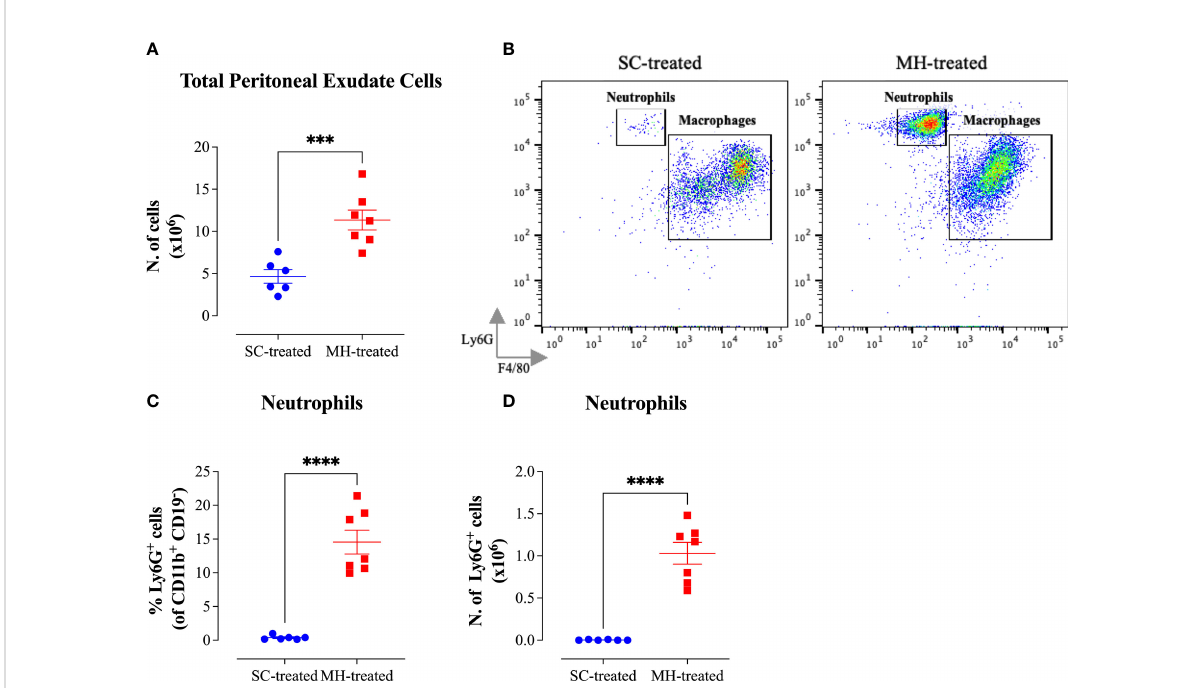
FIGURE 6 Cellular alterations in the peritoneal cavity following MH administration in C3H/HeJ mice. (A) Total number of PECs following treatment with SC or MH. (B) Representative dot plots showing Ly6G + neutrophils and F4/80 + macrophages within the PECs (gated on CD11b + CD19 - CD11c - cells). (C, D) Quanti fi cation of the percentage (C) and absolute number (D) of neutrophils (Ly6G + cells) in the peritoneal cavity of C3H/HeJ mice following treatment with SC or MH. Asterisks denote statistically signi fi cant differences between the MH-treated group and the SC-treated group. Asterisks denote statistically signi fi cant differences between the MH-treated group and SC-treated groups. The values for individual mice in a group ± SEM are shown (SC-treated: n=6; MH-treated: n=7), pooled from 2 individual experiments. p values were calculated using the unpaired Student ’ s t-test (***p ≤ 0.001, ****p ≤